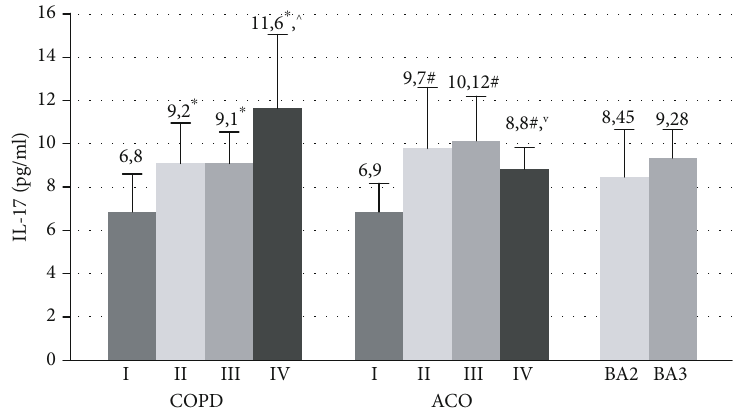
Figure 3: The serum concentrations of IL-17 in patients with COPD, ACO, and BA with varying severity of disease and airway obstruction. COPD: chronic obstructive pulmonary disease; ACO: asthma-COPD overlap; BA: bronchial asthma; I: GOLDI, ACOI; II: GOLDII, ACOII; III: GOLDIII, ACOIII; IV: GOLDIV, ACOIV; BA2: moderate bronchial asthma, BA3: severe bronchial asthma; ∗ p < 0 : 05 versus patients with GOLDI, ^ p < 0 : 05 versus patients with GOLDII and GOLDIII; ∨ p < 0 : 05 versus patients with ACOIV; # p < 0 : 05 versus patients with ACOI.